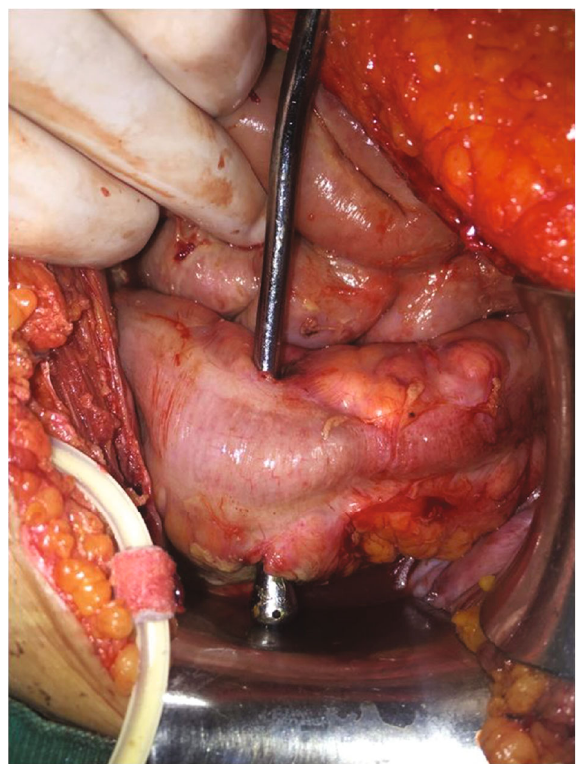
Figure 1: Entry from the sigmoid colon mesocolon. Figure 2: Perforated localization of the sigmoid